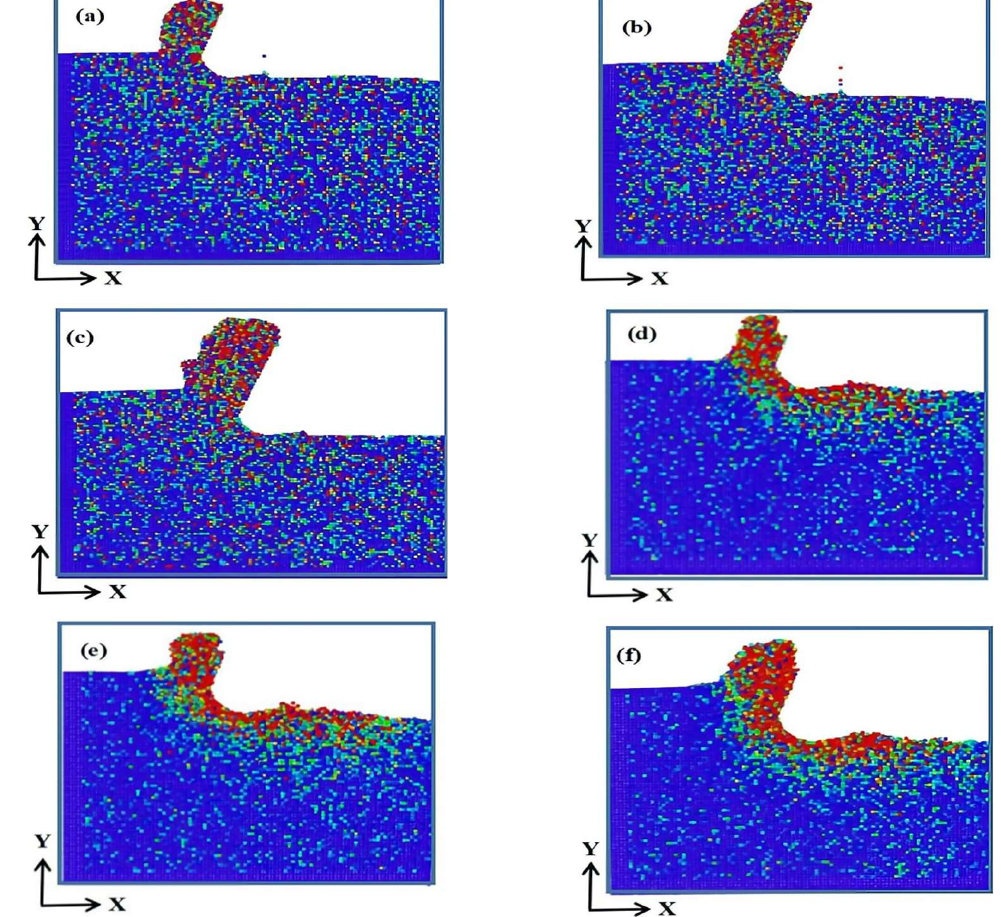
Figure 6. Internal temperature of workpiece under different cutting environments (( a ) cutting depth is 2 nm and without water medium ( b ) cutting depth is 3 nm and without water medium ( c ) cutting depth is 4 nm and without water medium ( d ) cutting depth is 2 nm and with water medium ( e ) cutting depth is 3 nm and with water medium ( f ) cutting depth is 4 nm and with water medium).